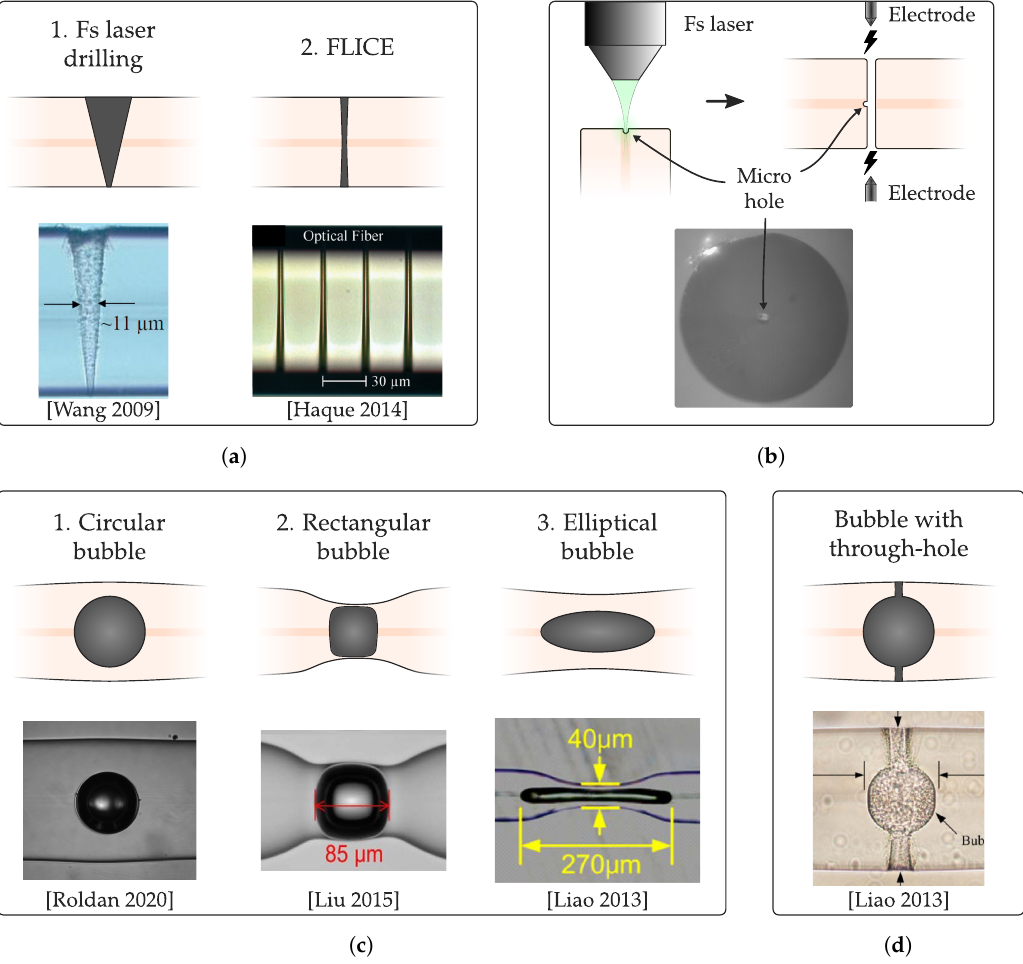
Figure 12. ( a ) Cavities that present access ports with the surrounding medium. They can be manufactured by fs laser drilling of optical fiber (adapted with permission from [137], ©The Optical Society) (1), or by the FLICE technique [8] (2). ( b ) Manufacturing process of in-fiber air bubbles by fs laser micromachining of a fiber end-face and subsequent splice [17]. ( c ) Using the technique of Figure 12b, creation of circular bubbles (adapted with permission from [17], ©IEEE) (1), rectangular bubbles by suitable parameters in the splice [133] (2), or bubbles with great ellipticity through fiber tapering (adapted with permission from [135], ©The Optical Society) (3). ( d ) In-fiber bubble with channels to the surrounding medium (adapted with permission from [136], ©The Optical Society). Combination of the methods of Figure 12a,c, in that